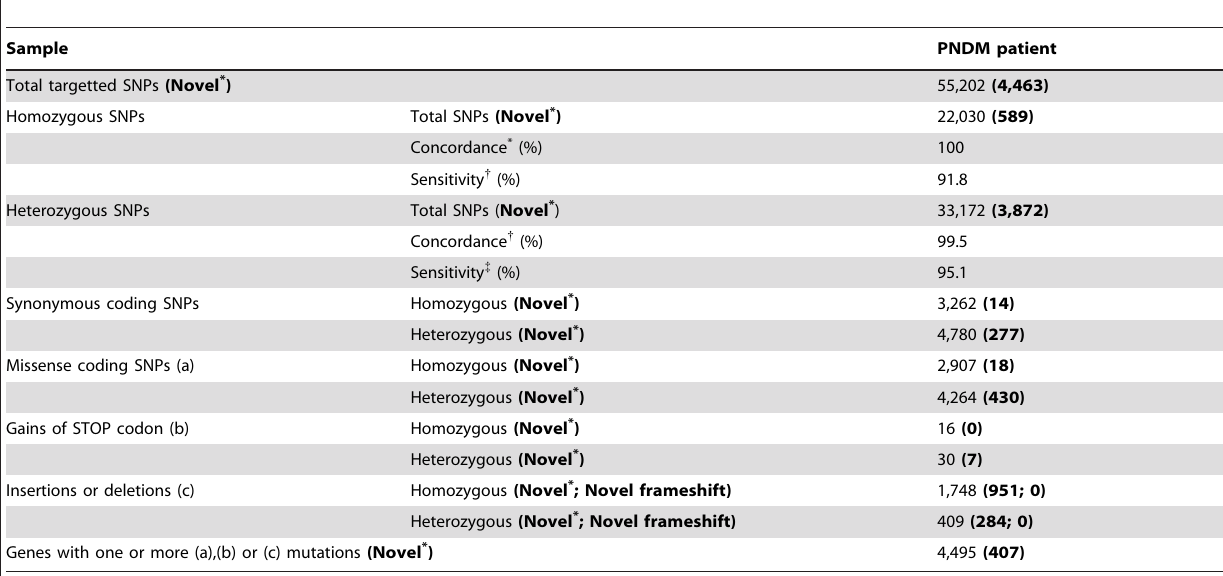
Table 1. Number of mutations identified through the WES analysis of DNA sample from the PNDM patient.